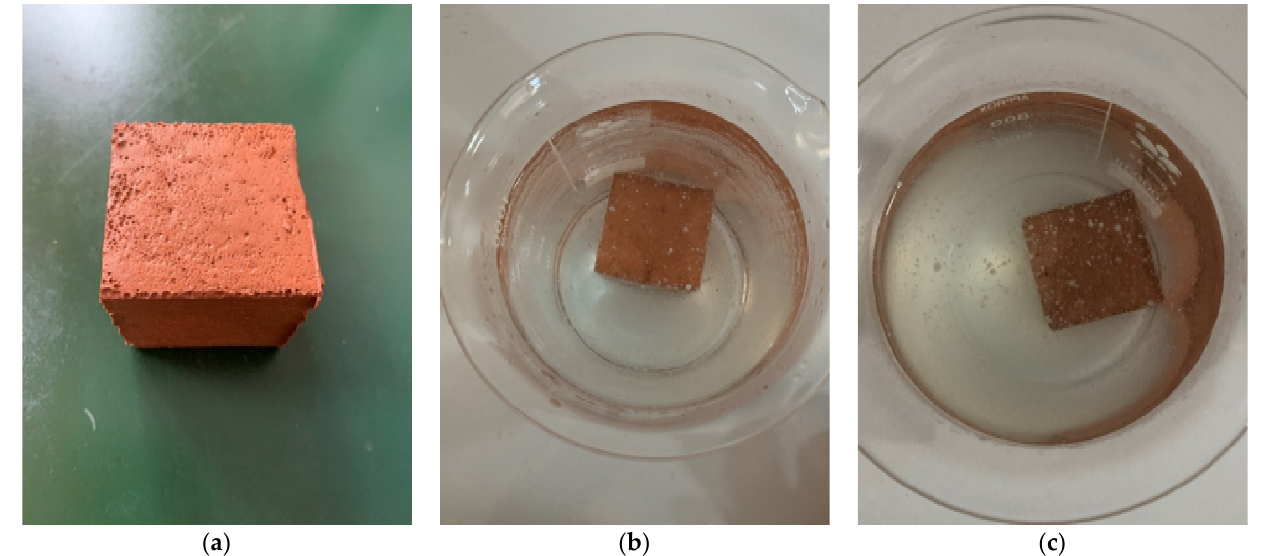
Figure 6. Alkali ‐ activated coal ‐ based metakaolin specimen before immersion ( a ), after immersion for 3 days ( b ) and 10 days ( c ).